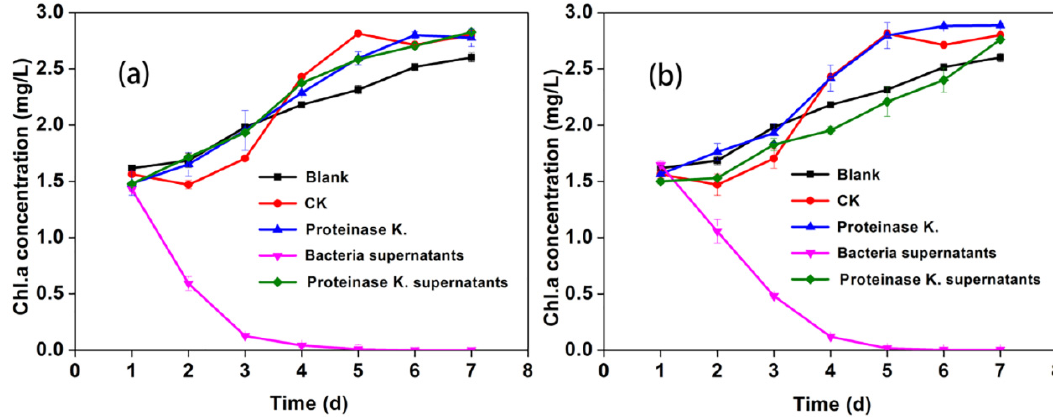
Figure 9. The effects of bacterial culture liquid supernatant treated with protease K on chlorophyll-a of Microcystis aeruginosa ( a ) strain 39 # and ( b ) strain 91 # .